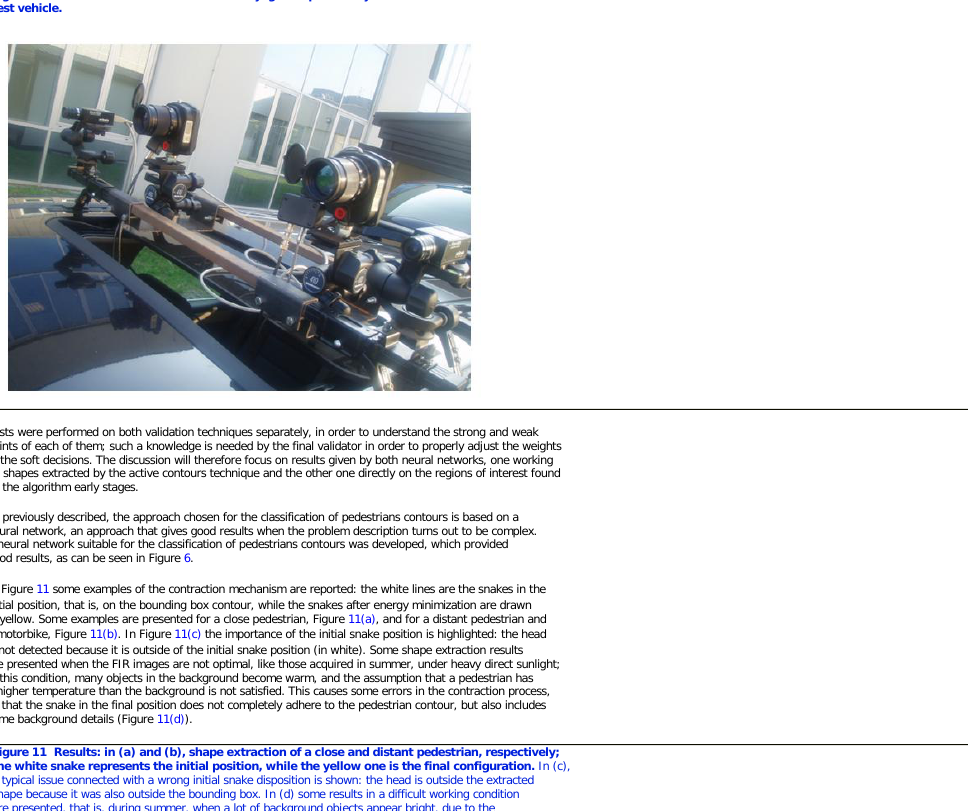
Figure 11 Results: in (a) and (b), shape extraction of a close and distant pedestrian, respectively; the white snake represents the initial position, while the yellow one is the final configuration. In (c), a typical issue connected with a wrong initial snake disposition is shown: the head is outside the